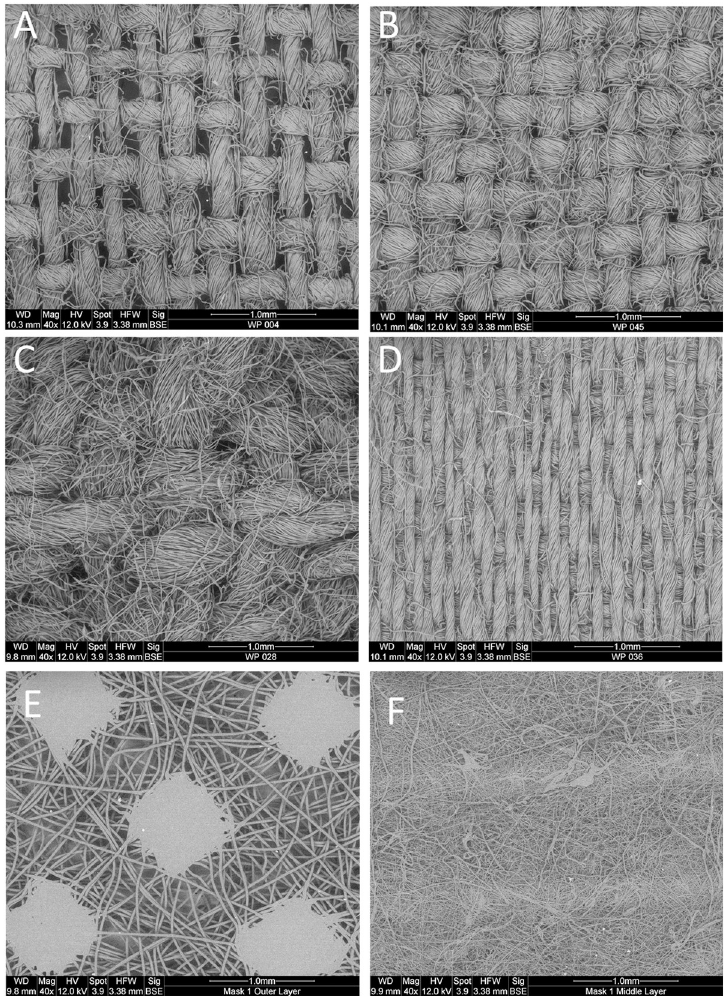
Fig 2. Electron microscopy images of selected fabrics. A) WP004 Bandana with plain weave, B) WP045 High Quality Quilting Fabric with plain weave, C) WP028 tea towel with complex weave; D) WP036 Bed Sheet with complex weave, E) Outer Layer L1 medical mask nonwoven, F) Middle Layer of L1 medical mask nonwoven. Microscope images for all 52 fabrics are provided in S2 File. density, pore diameter, pore area and % occupied area. High quality quilting cottons had the lowest CV across fabrics tested for 4 of the 5 measurement categories. Principle components analysis (PCA) on the cotton fabric measurements generated two component axes with eigenvalues greater than 1 and which cumulatively explained 76.8% of the variation in the data. Fig 3 presents a biplot of PCA scores across the first two PCA axis with samples grouped according to their fabric type while vectors present fabric measurement loadings. Fabrics positioned towards the left upper and lower quadrant exhibited generally smaller pore sizes and higher TPI. These included bed sheet and high quality batik at the extreme range followed by clustering of high quality quilting cotton, mass market quilting cot- ton and fashion fabric. Distinction between the upper and lower left quadrant of Fig 3 was mainly according to pore shape and number of vertical threads. Fabrics falling in the upper right quadrant included bandana and T-shirt were characterized by larger pore sizes and %